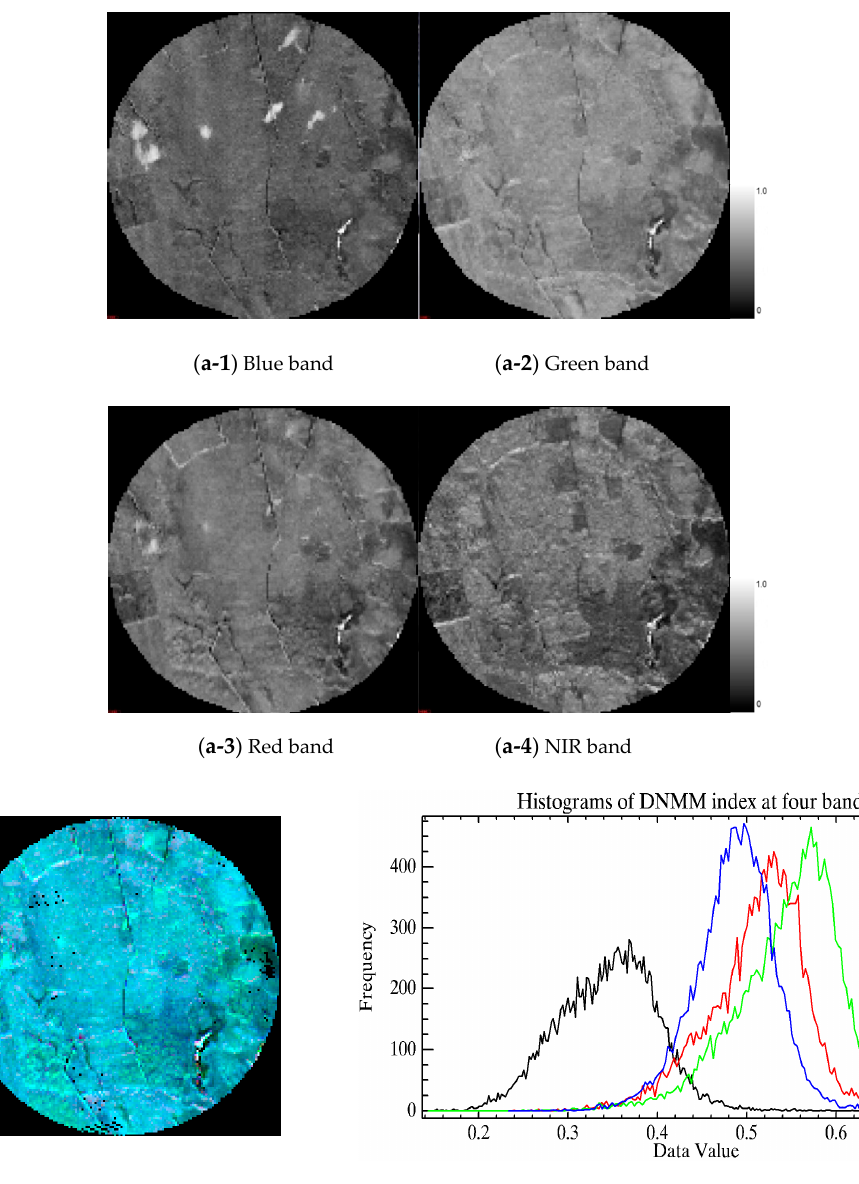
Figure 4. The normalized difference between the maximum and minimum reflectance (NDMM) index maps ( a-1 ), ( a-2 ), ( a-3 ), and ( a-4 ) are for the blue, green, red, and near-infrared bands, respectively: a false color image of the NDMM index ( b-1 ) (red: NIR spectral band, green: red spectral band, and blue: blue spectral band), and histograms of the NDMM index at four bands’ tree height ( b-2 ) (the blue line is the NDMM index at the blue band, the green line is the NDMM index at the green band, the red line is the NDMM index at red band, and the black line is the NDMM index at the NIR band).